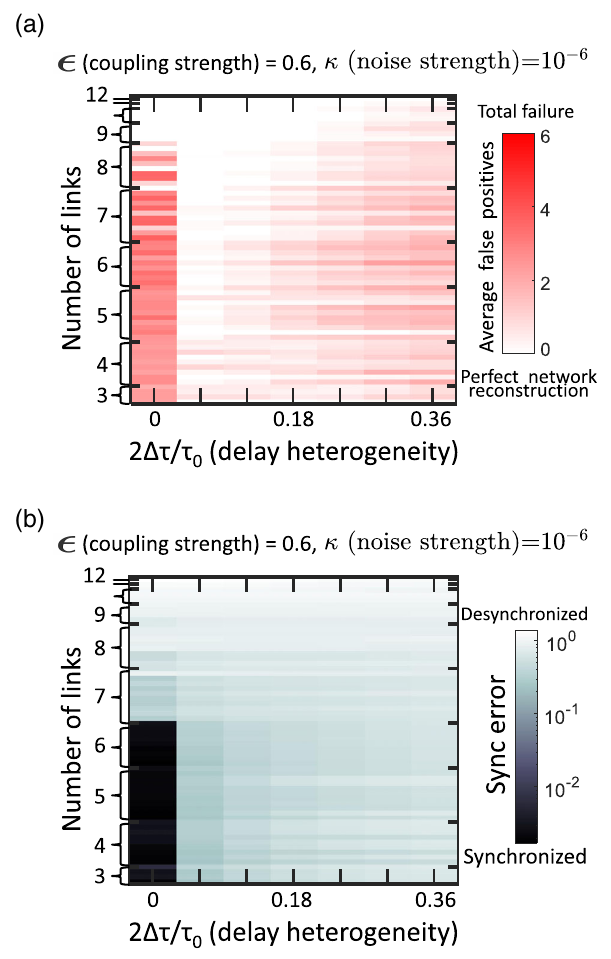
FIG. 10. Tests on networks with heterogeneous link delays. (a) Average number of false positives and (b) the corresponding synchronization error for different networks listed in Fig. 4, with ϵ ¼ 0 . 6 and κ ¼ 10 − 6 , and different amounts of link delay heterogeneity, presented as the ratio of link delay variation range 2 Δ τ and mean link delay τ 0 . The results are based on simulated data with different network configurations and different random link delays along the network links. In each case, the averaging is done over 100 different random realizations of reservoir con- nections, initial conditions, and assignments of interaction delays to different links. The convention for sequence of the networks is the same as in Fig.